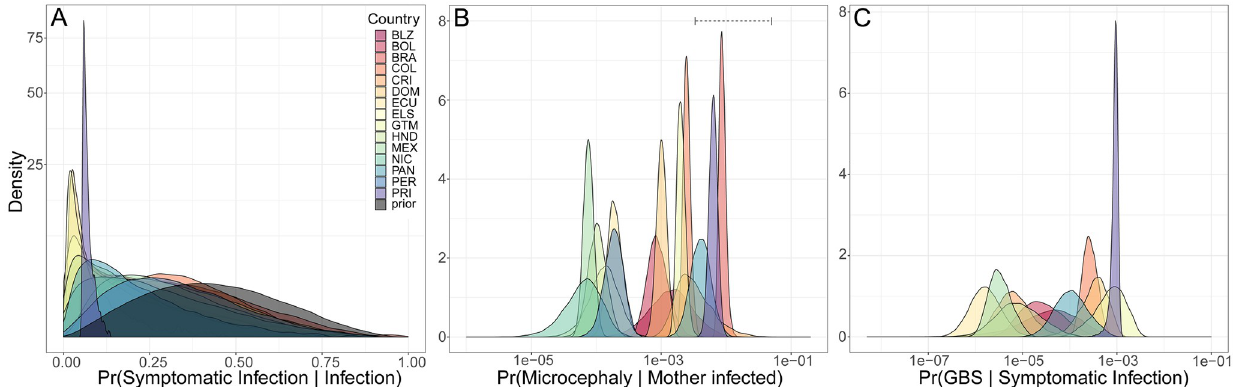
Fig 4. Posterior parameter estimates. (A) Posterior and prior symptomatic probability estimates for each country or territory. (B) Posterior estimates from each country and territory of the probability that a ZIKV infection in a pregnant woman results in a reported case of microcephaly. Dashed line represents range for estimated risk of Zika-associated microcephaly from published observational studies (see text for references). (C) Posterior estimates from each country and territory of the probability that a symptomatic infection results in a reported Guillan-Barre´ syndrome (GBS) case.